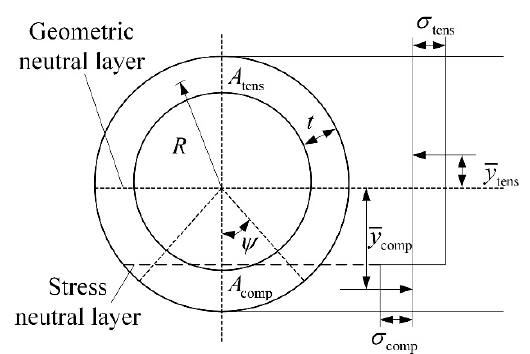
Figure 6. Stress distribution of pipe section.